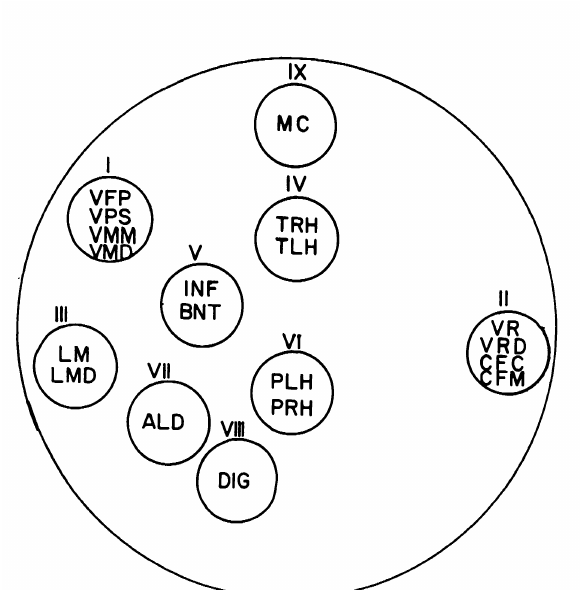
FIG. 1. Graphic representation of the nine factors disclosed in the neuropsychological test battery.